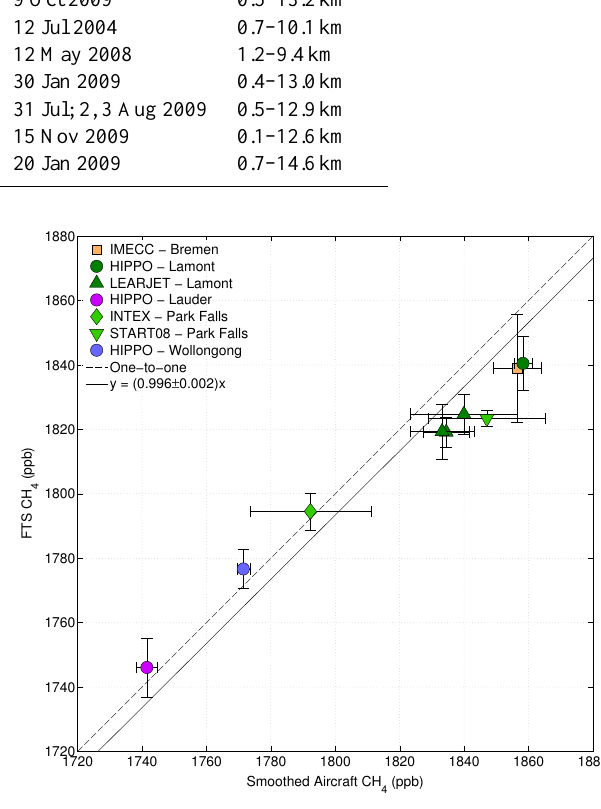
Figure 8. Tropospheric CH 4 column comparison for TCCON vs. aircraft profiles. Error bars denote the 2 σ standard deviation from the daily median (FTS) and the estimated instrument errors and tro- pospheric uncertainty of the measurements